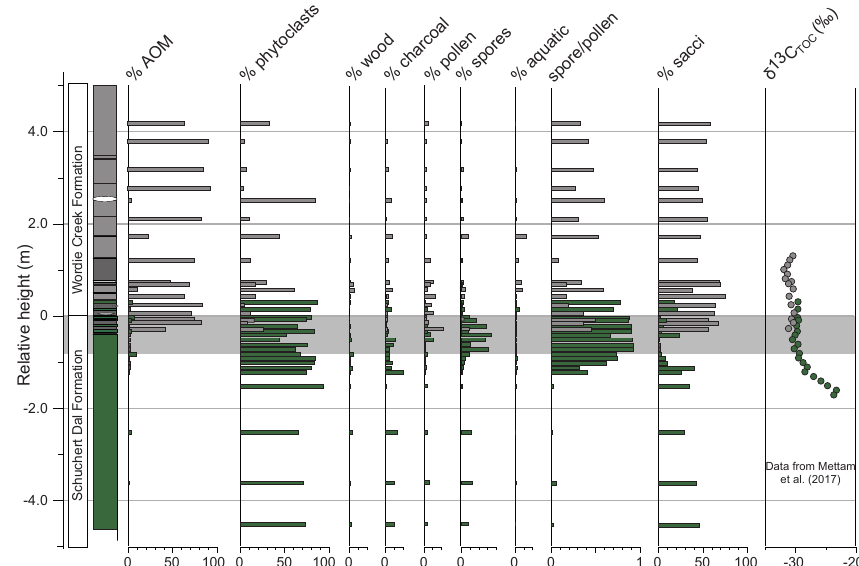
Figure 2. Change in major groups of palynofacies. AOM: amorphous organic matter. The grey shaded box highlights the biotic crisis as defined by the high spore:pollen ratios, which are indicative for the disappearance of forest communities. Green shading indicates data from bioturbated rocks; grey shading indicates data from laminated rocks. Grey horizontal bar indicates the extinction interval, based on high spore:pollen